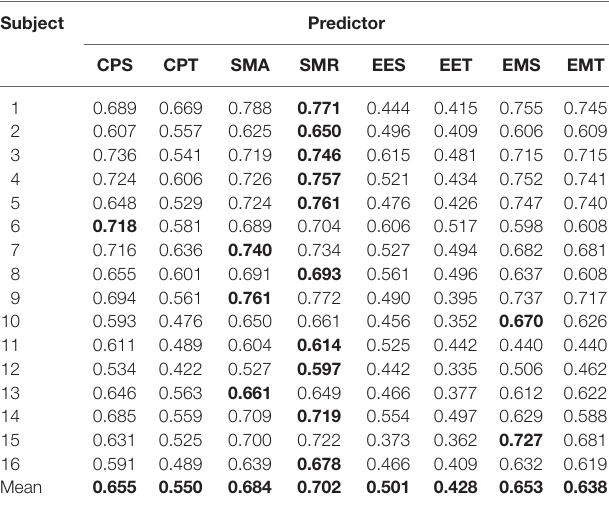
TaBle 1 | Predictors result.